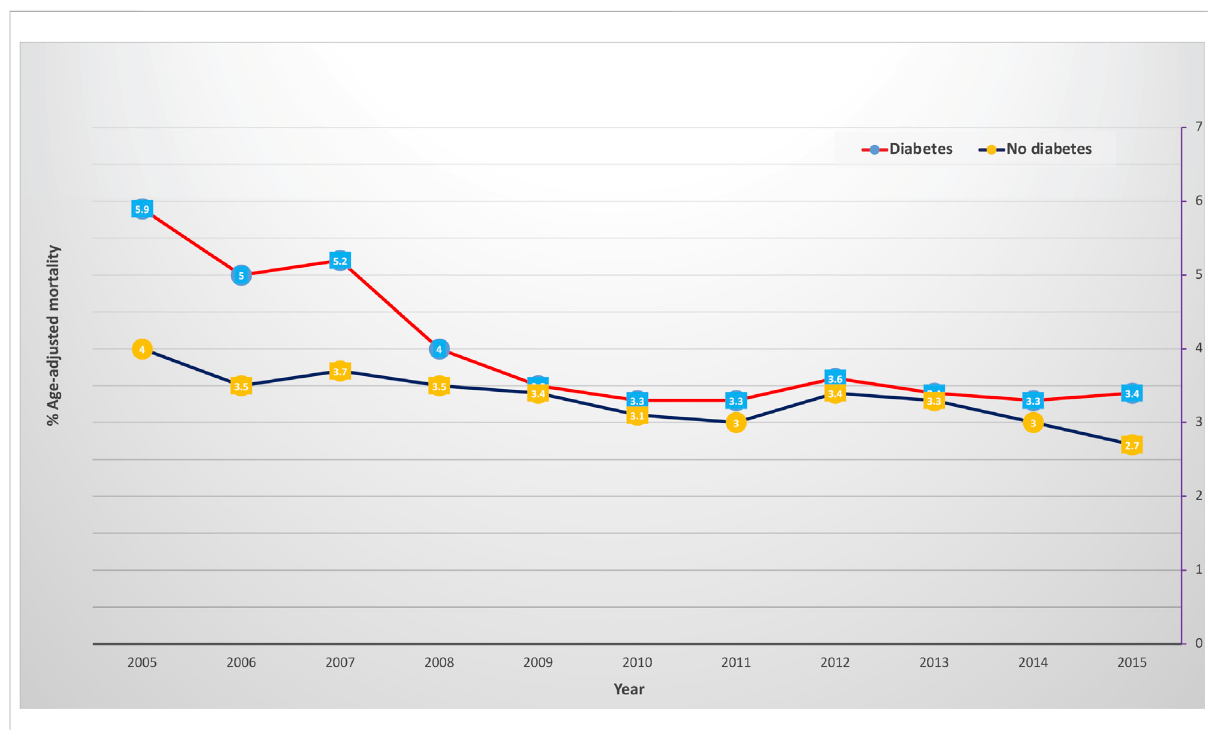
FIGURE 2 In-hospital mortality trend in patients with hypertrophic cardiomyopathy, heart failure, and diabetes (red color) and without diabetes (blue color). The X-axis represents the percentage of in-hospital mortality. The Y-axis represents the